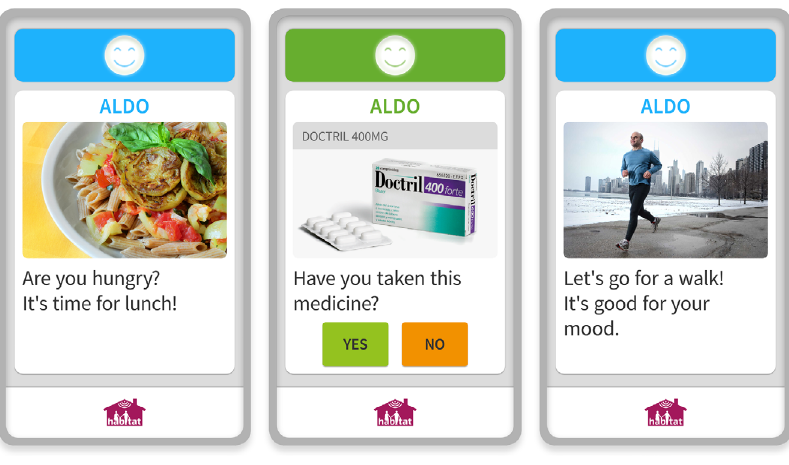
FIG. 4 Some screens of the HABITAT interface. Source: GA. Giacobone,